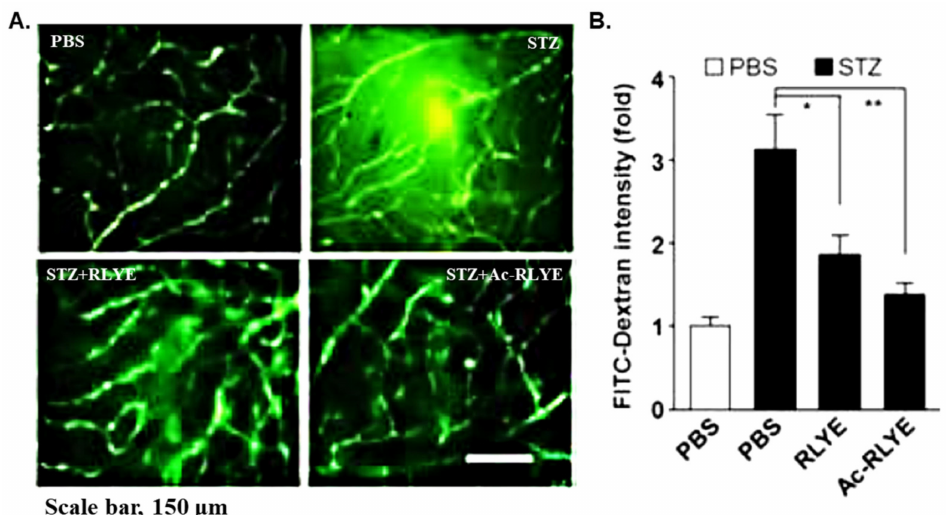
Figure 2. The effects of the intravitreal administration of RLYE and Ac-RLYE on inhibition of retinal vascular leakage in streptozotocin (STZ) induced diabetic mouse models. ( A ): Representative image of a retinal flat mount observed under a confocal microscope following injection of FITC-dextran into the left ventricle at 24 h after the substance treatment, ( B ): Measurement of the fluorescence of FITC-dextran leaked from retinal vessels by Fluoview software ( n = 4 mice per group). The retinal vascular leakage increased in STZ-induced diabetic retinopathy mice was significantly inhibited by RLYE (*, 0.01 < p < 0.05) and Ac-RLYE (**, p <